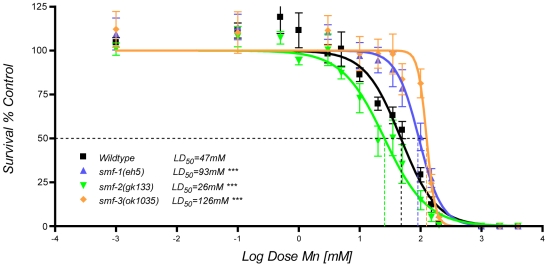
Dose-response lethality curves reveal a differential sensitivity to Mn exposure for smf mutants compared to wild type worms.Upon 30 min exposure to MnCl2 as L1 larvae the lethal concentration 50 (LD50) at which half of the worms were dead at 24 h, was 47 mM for wildtype worms (black, N = 12), 93 mM for smf-1 mutants (blue, N = 6), 26 mM for smf-2 mutants (green, N = 7), and 126 mM for smf-3 mutants (orange, N = 5). Error bars represent SEM, *** p<0.001.